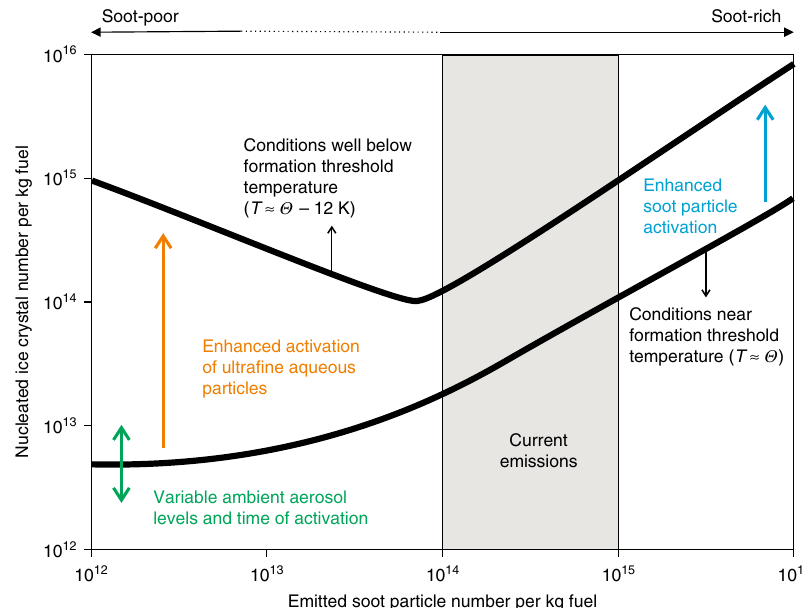
Fig. 3 Nucleation of ice crystals in jet aircraft exhaust plumes. Ice crystal number emission index (per kilogram of fuel burnt) in the jet regime as a function of the number emission index of emitted soot particles simulated by a parcel model 37 . Two results are shown for an ambient temperature, T , close to a contrail formation threshold temperature, Θ ≈ 225 K, frequently found in extratropical cruise conditions, and a rather low temperature 12 K below this value. At intermediate ambient temperatures, nucleated ice crystal numbers increase due to enhanced water activation of either soot or ultra fi ne aqueous plume particles (Box 1). An approximate range of current in- fl ight soot emission indices is indicated (hatched area). In soot-rich exhaust, the number of soot particles that can be water-activated and freeze increases with decreasing ambient temperature that in turn increases plume cooling rates and levels of plume supersaturation over liquid water. As T approaches Θ in soot-poor exhaust, ambient aerosol particles mixed into exhaust plumes are the only source of contrail ice crystals, as increasingly fewer plume particles can be activated owing to diminishing plume supersaturation; the number concentrations of ambient particles are much lower in contrails than current soot emission levels. The plume cooling rate determines the time of water